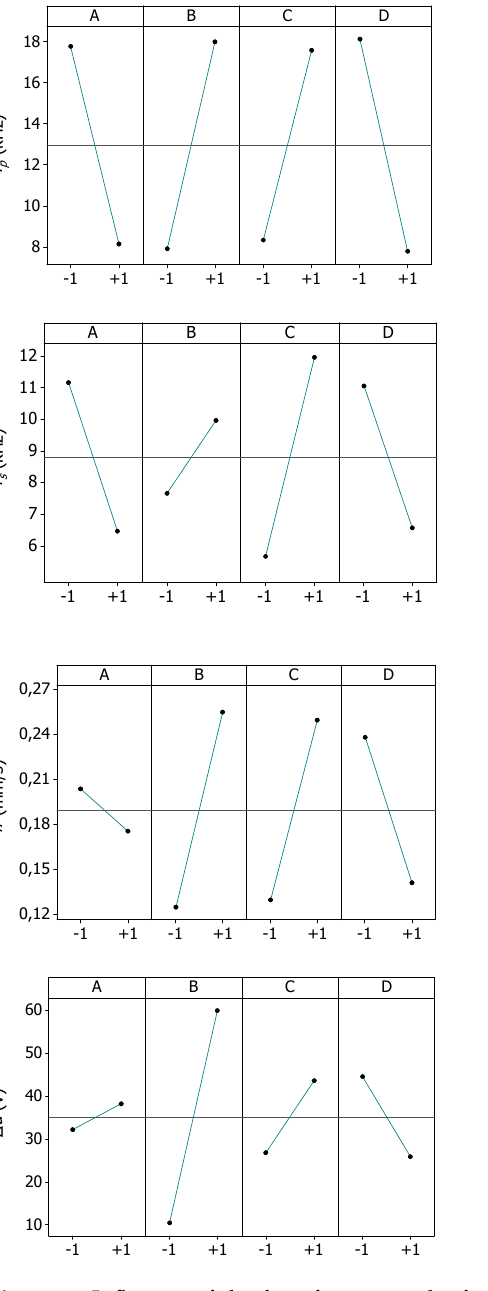
Figure 5. Influence of the four factors on the four potential indicators for the process fingerprint. The main effects plots (left column) and Pareto charts of the standardized effects (right column) are shown. The red vertical line in the Pareto charts corresponds to the significance level at 95% confidence level.